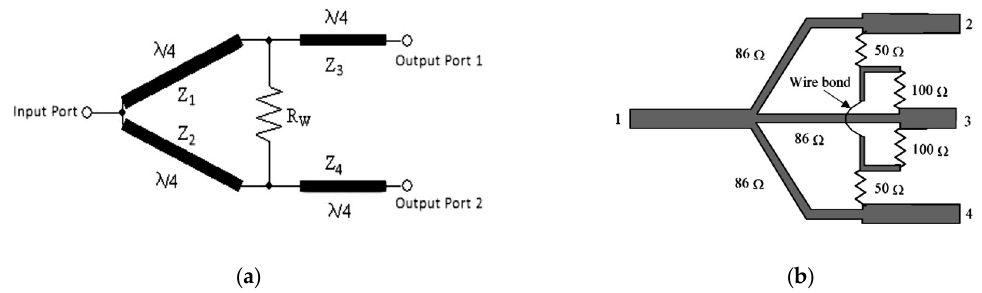
Figure 18. ( a ) Topology of unequal Wilkinson power splitter which uses a resistor that is normally open circuited (even mode) and does not generate loss ( b ) Compact micro-strip three-way Wilkinson power divider